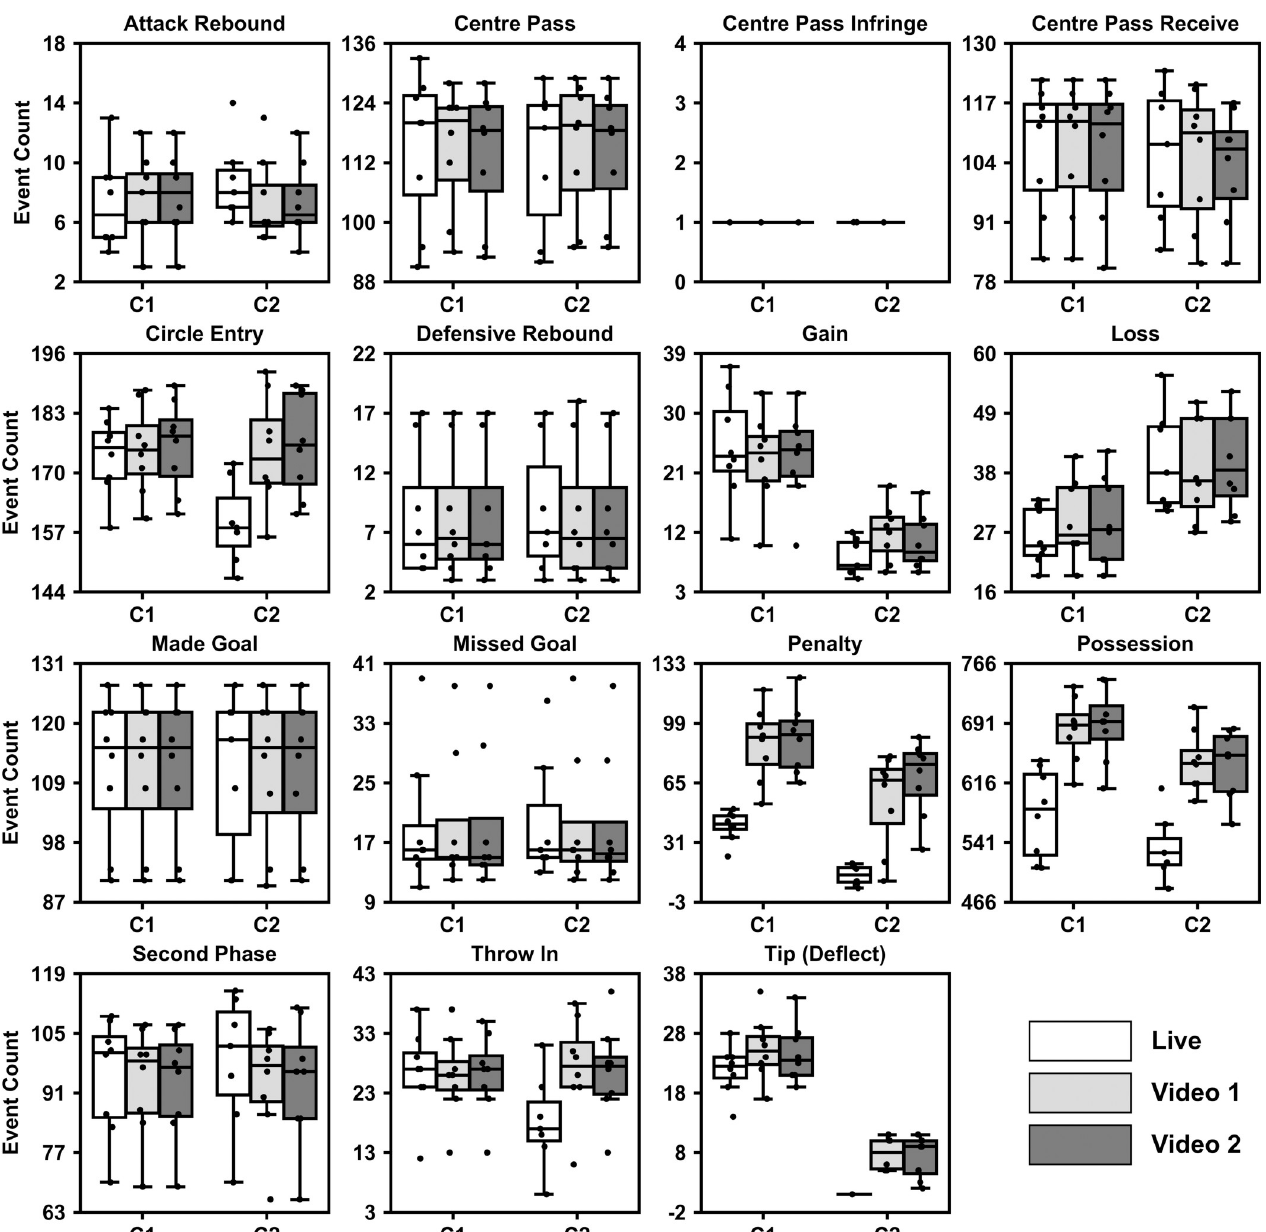
Fig 1. Box and whisker plot for the frequency of coded events for Victorian Netball League (VNL) and Suncorp Super Netball matches combined across the different coders (i.e., C1 and C2) and coding conditions (i.e., Live, Video 1 and Video 2). The horizontal line within boxes represents the median value, while the outer borders of the box represents the 25 th to 75 th quartiles of the data. Error bars represent the 1.5 inter-quartile range. Individual frequency counts are specified by the singular plotted points.